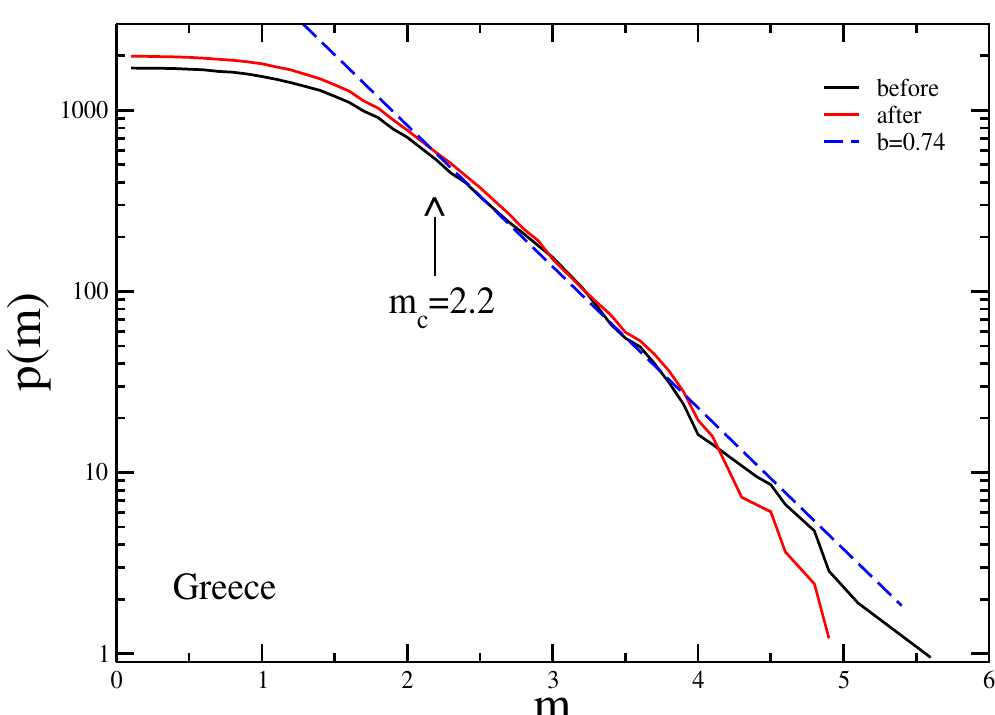
Figure 3. The Gutenberg–Richter distribution for the Greece catalogue. The dashed line represents the fit for m ≥ m c